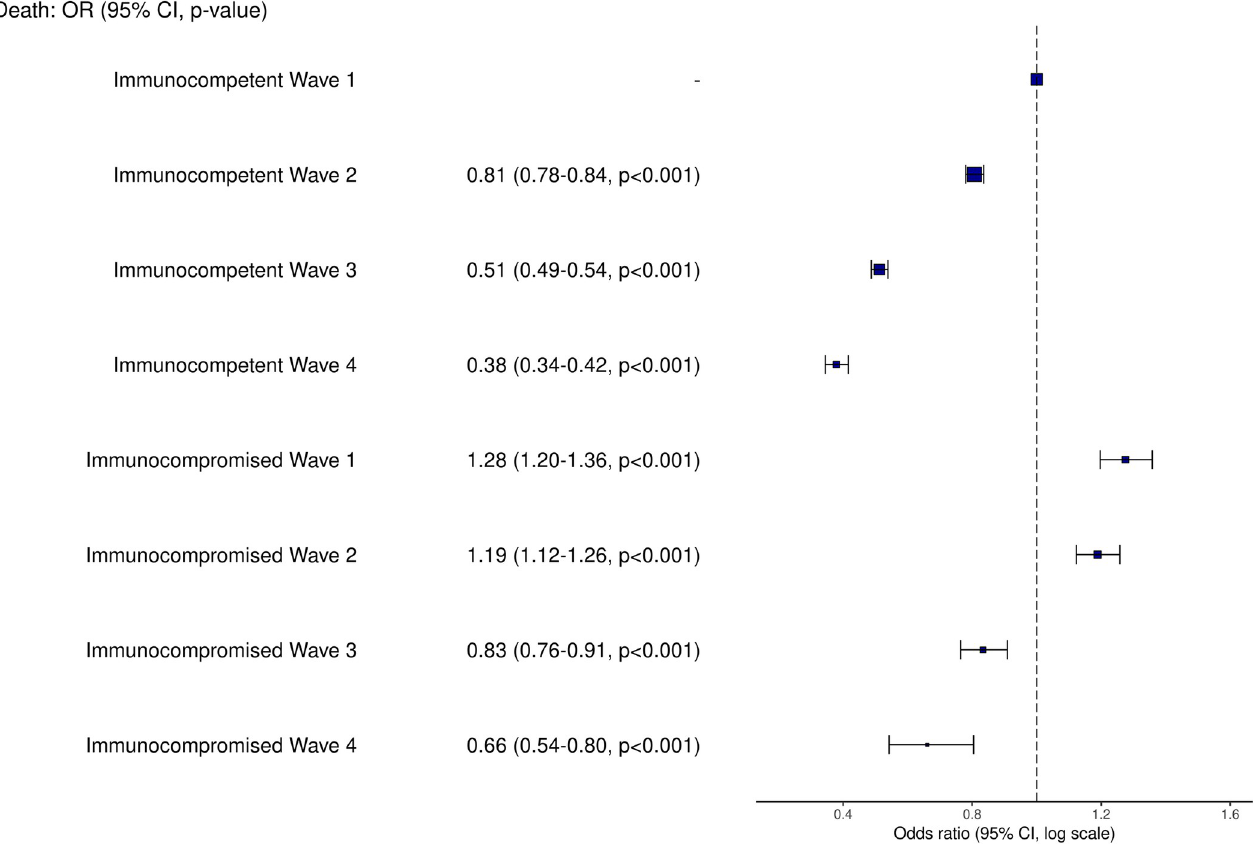
Fig 4. Outcomes of hospitalised immunocompromised patients, compared with immunocompetent patients over the first 4 pandemic waves in the UK. Odds ratios (ORs) from multivariable logistic regression and 95% confidence intervals (CIs) for outcomes of death, broken down by pandemic wave, adjusted for age, sex, ethnicity, socioeconomic deprivation, comorbidity count (not including the immunocompromising condition), and vaccination status. Wave 1 was 17 January to 31 August 2020; wave 2 was 1 September 2020 to 31 March 2021; wave 3 was 1 April 2021 to 12 December 2021; and wave 4 was